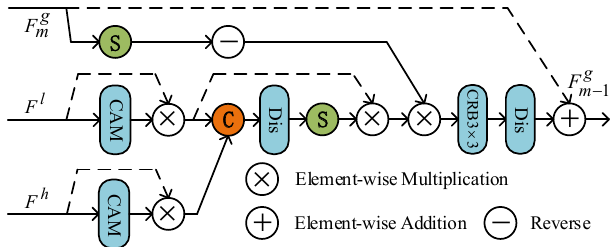
Figure 5. Illustration of parallel attention fusion (PAF)